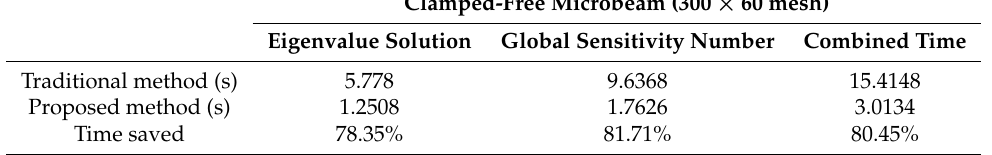
Table 2. The comparison of the average computational times of each iteration of topology optimiza- tion of the clamped-free microbeam resonator with the traditional linear method and the proposed